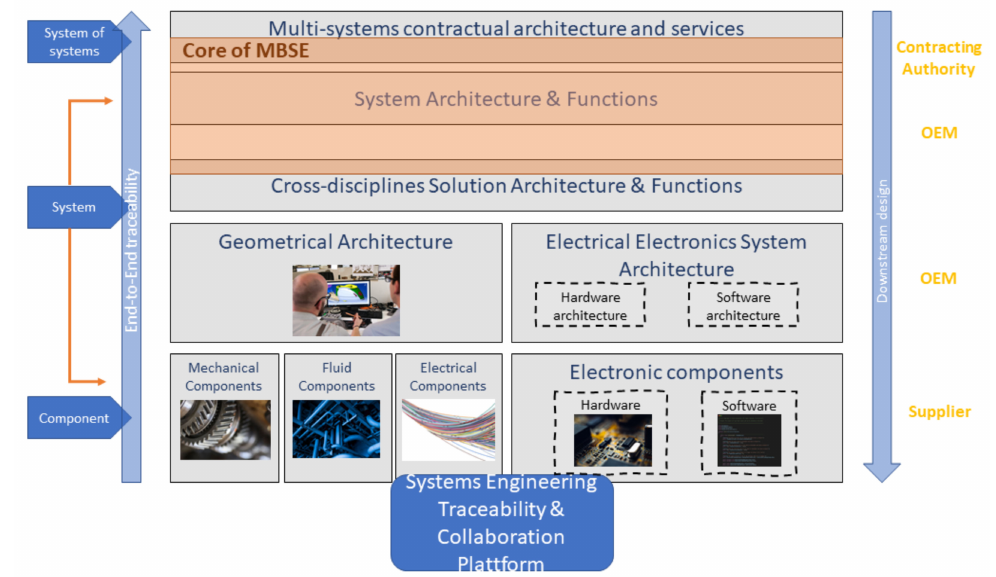
Figure 7. Model-Based Systems Engineering framework to support the consistency of exchanging